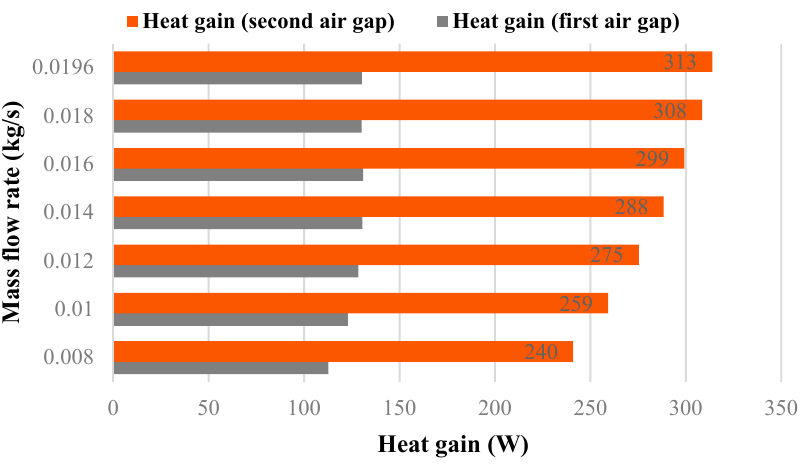
Figure 17. Contribution of air gaps in air preheating.